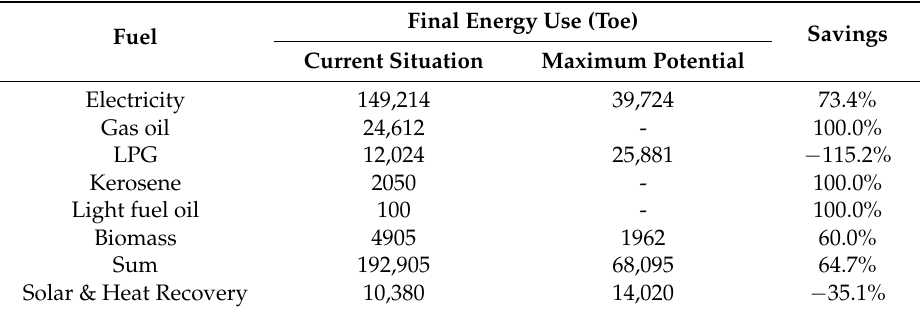
Table 4. Maximum theoretical energy saving potential in the Cypriot service